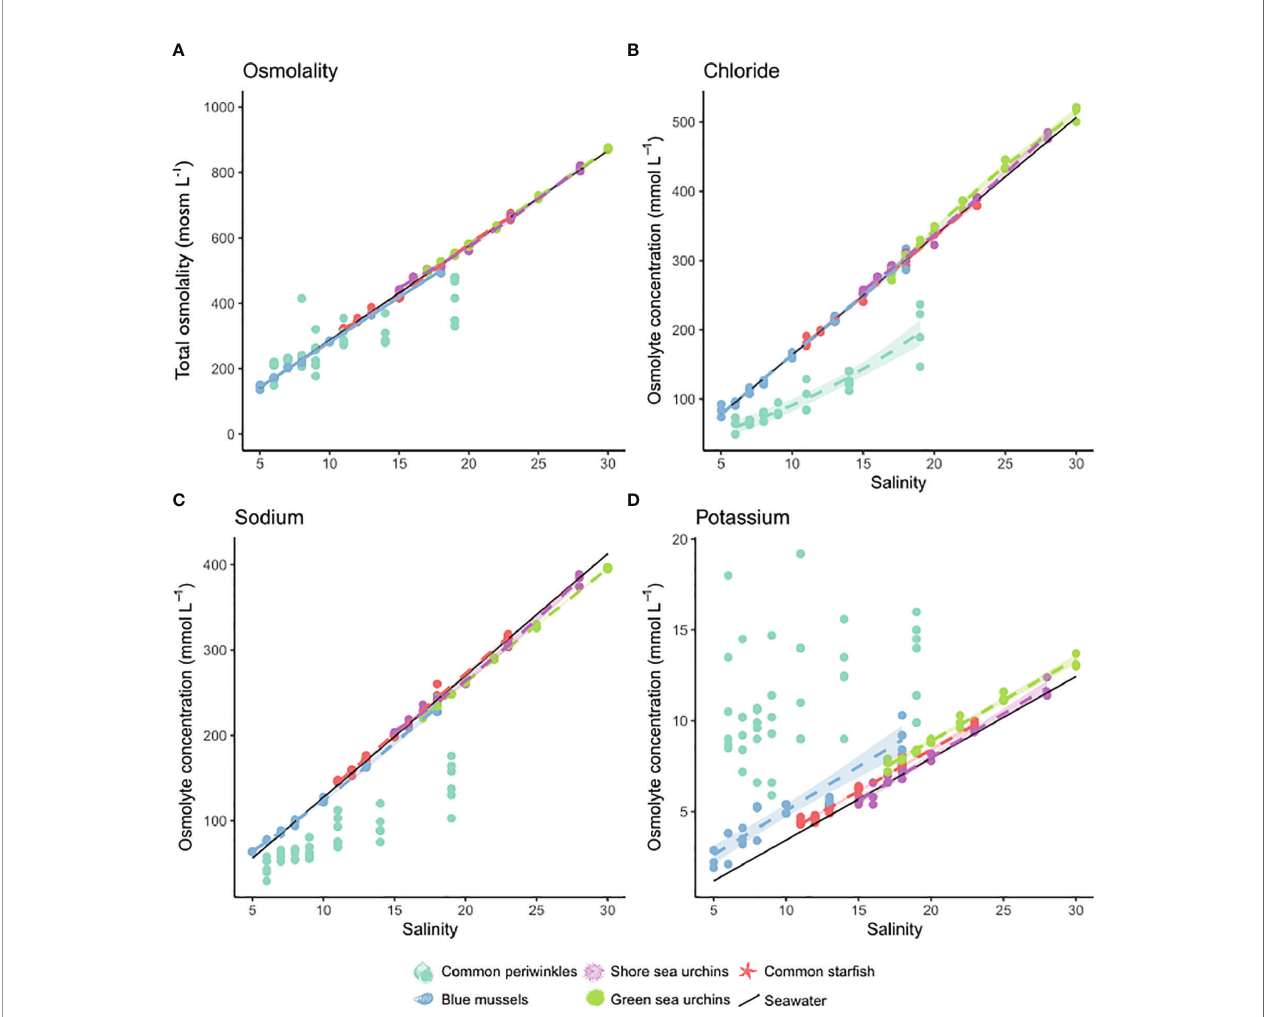
FIGURE 3 | Salinity effect of the major inorganic osmolytes in body fl uids of fi ve of the study organisms: blue mussels (blue, Mytilus sp.,) common periwinkles (turquoise, L. littorea ), shore sea urchins (purple, P. milliaris ), green sea urchins (green, S. droebachiensis ) and common star fi sh (red, A. rubens ). Concentration of total osmolality (A) , chloride (B) , sodium (C) and potassium (D) is shown on the y-axis (mmol L -1 or mosm L -1 ) and salinity is depicted on the x-axis. Models were chosen according to best fi t and their predicted values are depicted by lines. Only signi fi cant models were shown. If only data points are shown without a model, that means that there was no signi fi cant model, or assumptions were not met. Con fi dence intervals (95%) are shown as shaded area. No body fl uid samples were measured for orange-striped anemones. For model results see Table S5